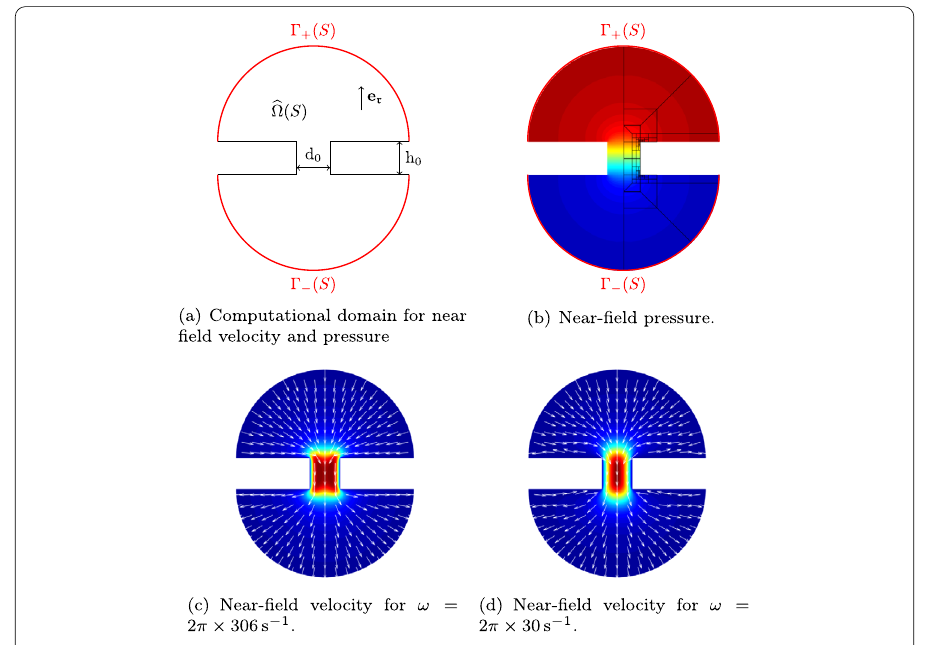
Figure 3 ( a ) Computational domain for the near field problem around a single hole. ( b ) The near field pressure (real part) for the liner configuration DC006 (see Table 1) at ω = 2 π × 306 s –1 using S = 40. ( c ), ( d ) The near field velocity (imaginary part) for the same configuration as ( b ) and for ω = 2 π × 30 s –1 . Here, the color coding corresponds to the amplitude and the arrows to the direction of the